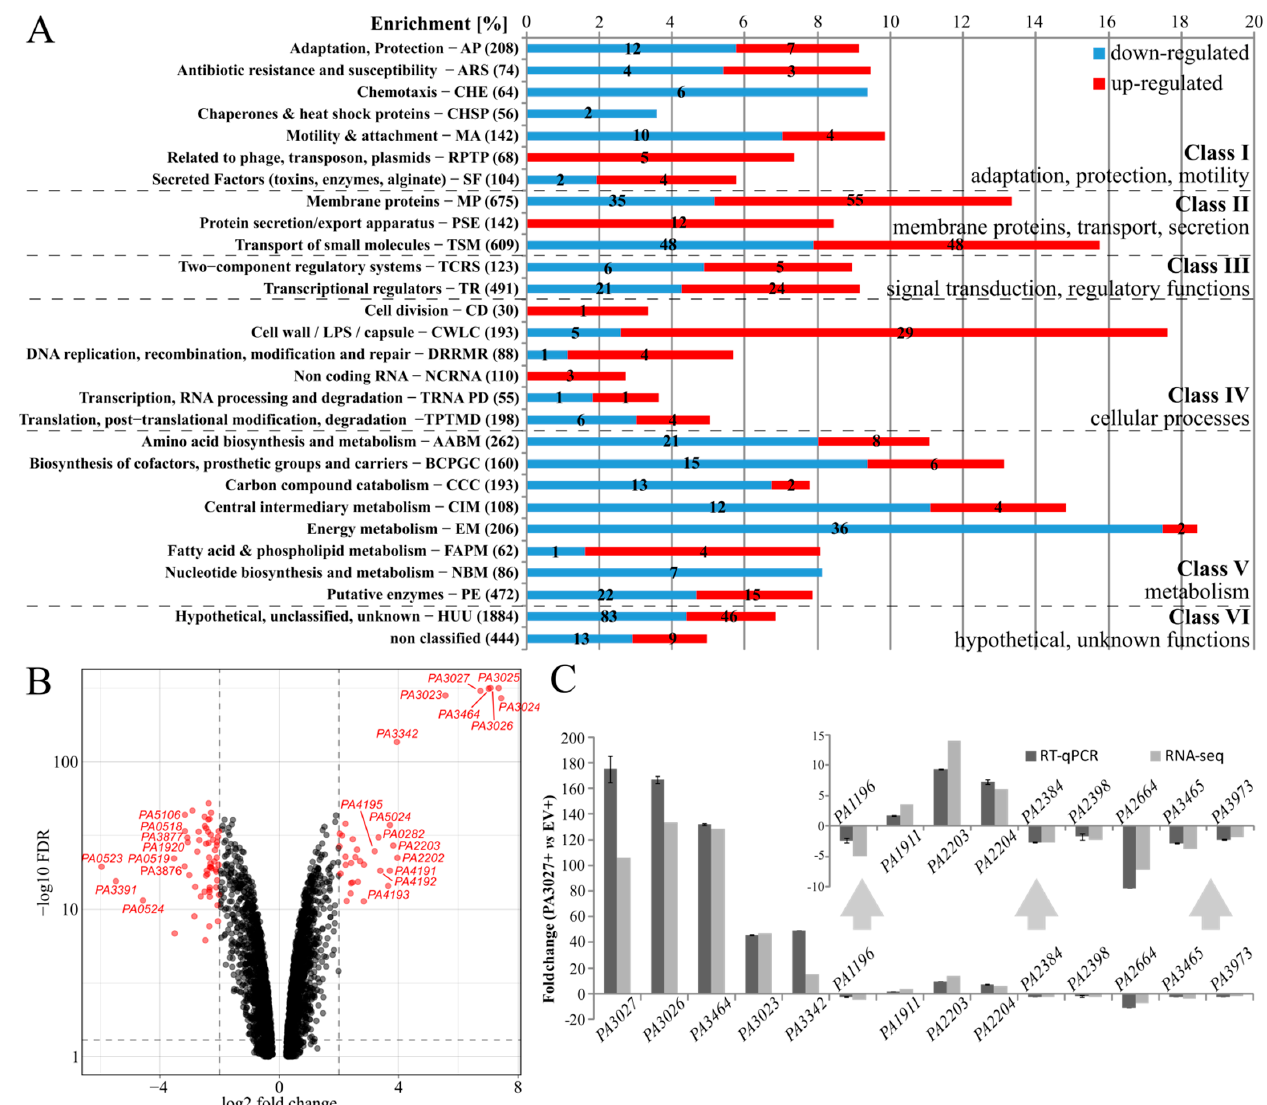
Figure 2. Effect of increased PA3027 level on gene expression in P. aeruginosa PAO1161 cells. ( A ) Enrichment of PseudoCAP functional categories [41] for 539 genes (306 downregulated; 233 upregulated) showing changes in mRNA level in response to PA3027 abundance (fold change ≤ − 2 or ≥ 2, FDR adjusted p -value ≤ 0.01). The numbers in brackets show the number of all genes in the PAO1 genome in the indicated PseudoCAP category. One gene could be classified into more than one category or class. Numbers in red or blue bars represent the number of up- or downregulated genes, respectively, in each category. The PseudoCAP categories were grouped into six more general classes. Genes annotated only in PAO1161 strain but not in PAO1 are described as non classified. ( B ) Volcano plot visualization of the results of differential expression analysis between transcriptomes of PA3027 overproducing cells and control cells. Each dot represents one gene and genes with the most significant changes are colored in red. For clarity genes with p -value < 0.1 are not shown. ( C ) Validation of RNA-seq results by RT-qPCR analysis. The same RNA used for RNA-seq analysis was used for cDNA synthesis and RT-qPCR analysis. Data represent mean fold change for three samples of PA3027 overproducing cells relative to the mean of the control samples ± SD.